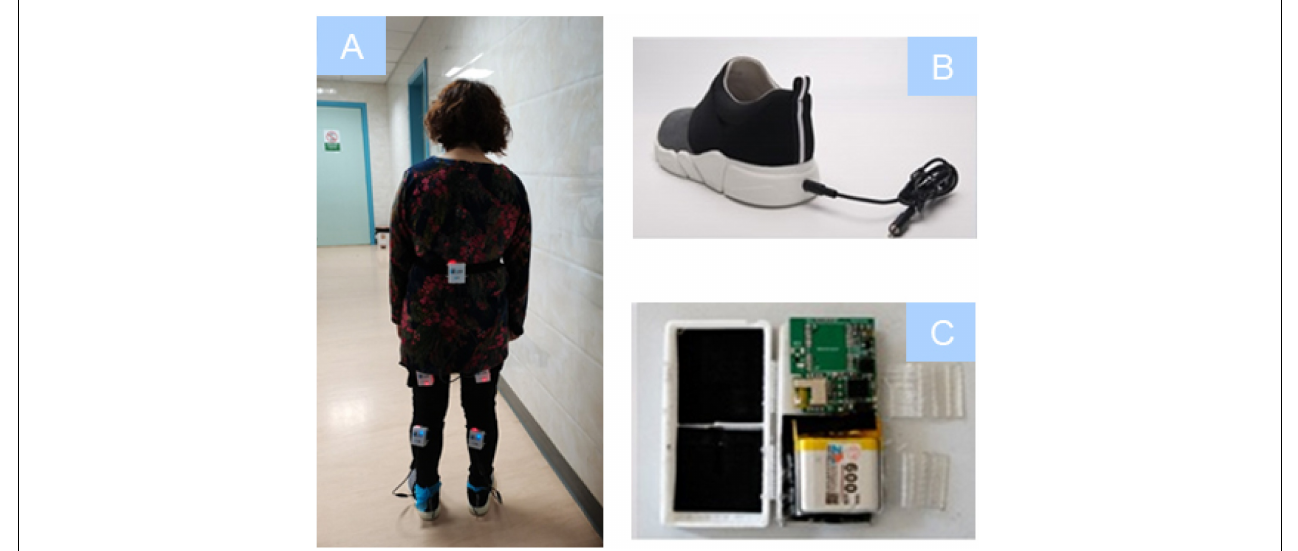
FIGURE 2 | The modules (A,C) and shoes (B) of JiBuEn TM wearable